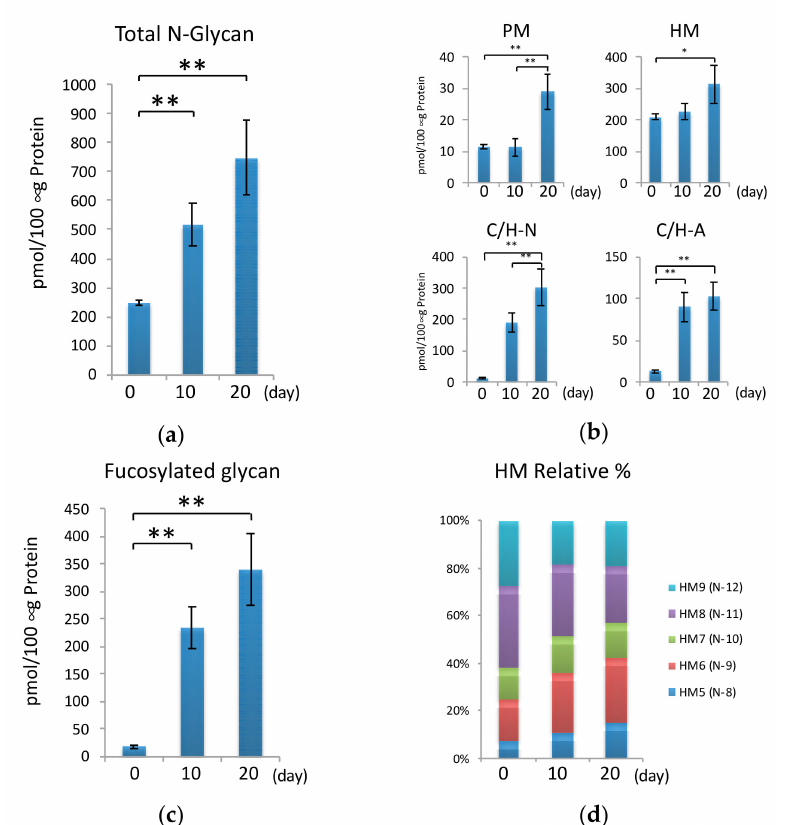
Figure 4. Total cellular N-glycome during hypertrophic di ff erentiation. ( a ) Total amount of N-glycan in cells at each time point (day 0, 10, and 20). ( b ) Amount of each class of glycan. Pauci mannose (PM); high mannose (HM); complex / hybrid neutral (C / H-N); and complex / hybrid acidic (C / H-A)-types. ( c ) Total amount of fucosylated N-glycan in C / H-N- and C / H-A-types. ( d ) Relative amount of high mannose-type N-glycans. At each time point, the ratio of the high-mannose glycan (HM5-9) was calculated when the total value of the HM glycan was taken as 100%. The results are expressed as the means ± standard deviation (S.D.). * 0.01 < p < 0.05; ** p < 0.01. All MALDI-TOF-MS measurements were independently carried out ( n = 3). The prepared glycan structures are listed in Supplementary Table